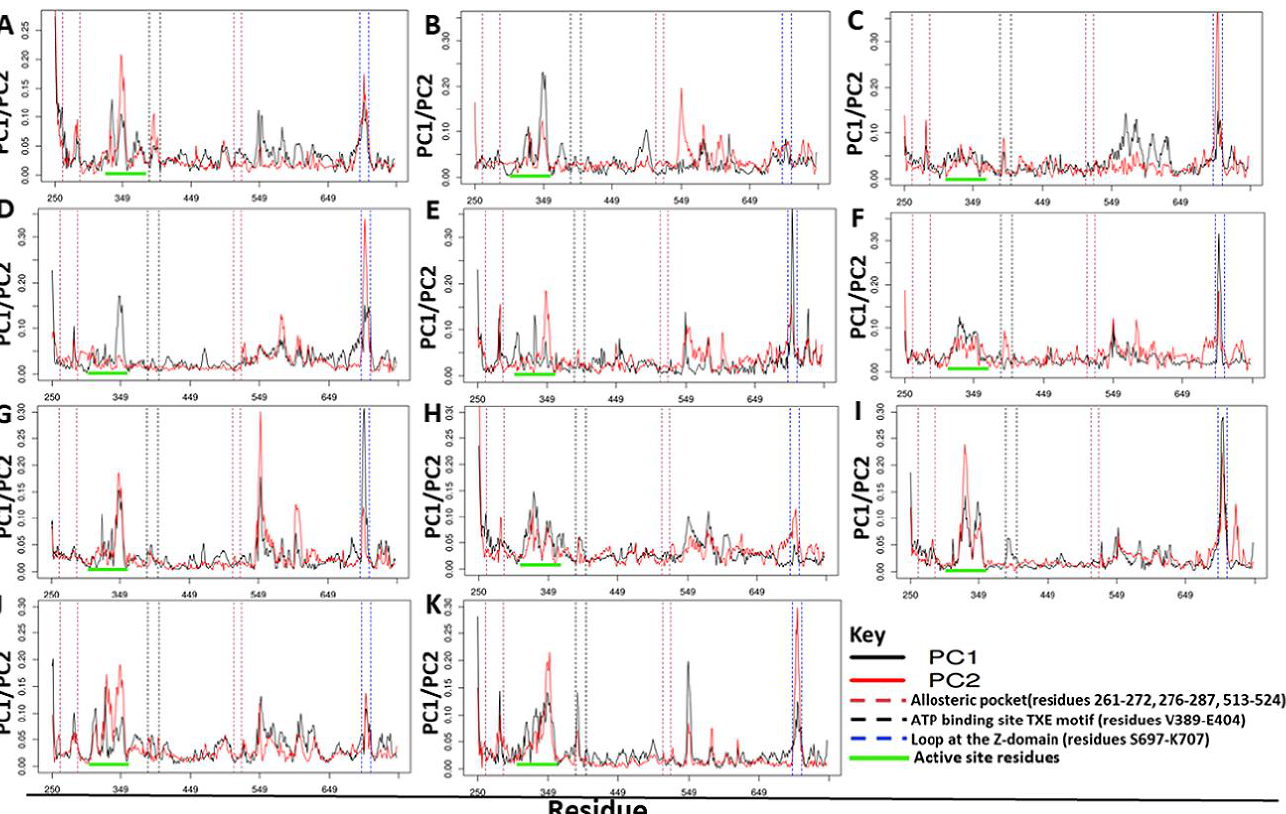
Figure 9. Contribution of each residue to PC1 and PC2. PC1 is shown in black while PC2 is shown in red for all the ligand-bound complexes. ( A ) Holo protein, ( B ) PfProRS-SANC152 complex, ( C ) PfProRS-SANC235 complex, ( D ) PfProRS-SANC236 complex, ( E ) PfProRS-SANC244 complex, ( F ) PfProRS-SANC318 complex, ( G ) PfProRS-SANC184 complex, ( H ) PfProRS-SANC257 complex, ( I ) PfProRS-SANC264 complex, ( J ) PfProRS-SANC456 complex and ( K ) PfProRS-SANC622